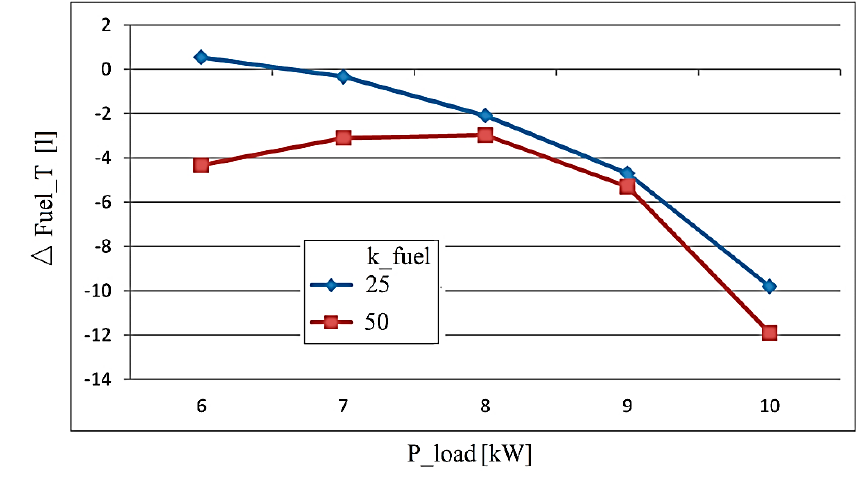
Figure 9. ∆ Fuel T registered in Table 5. Figure 9. ΔFuel Figure 9. ΔFuel (cid:2904) registered in Table 5. (cid:2904) registered in Table 5.